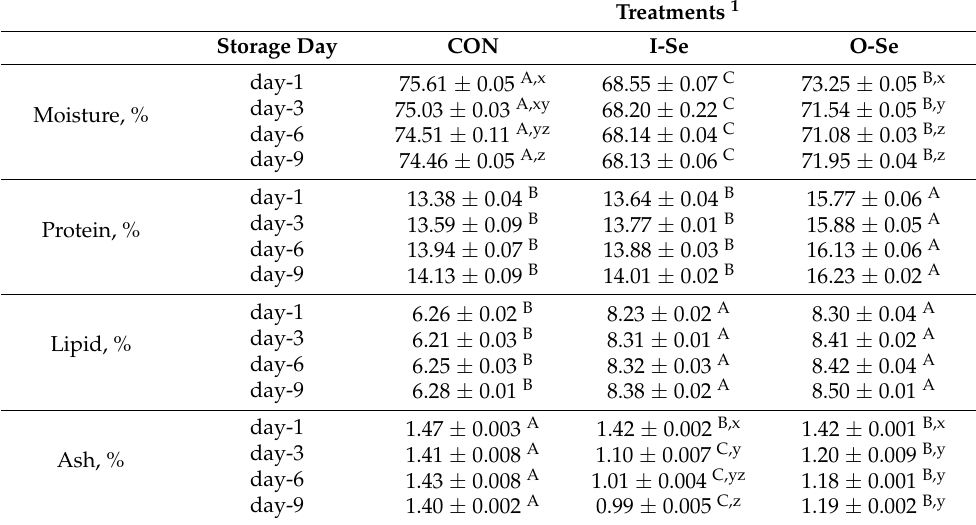
Table 3. Effects of dietary supplementation with inorganic or organic selenium on the chemical composition for liver of native Azerbaijan